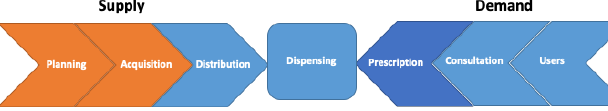
Figure 4. Drug supply process.